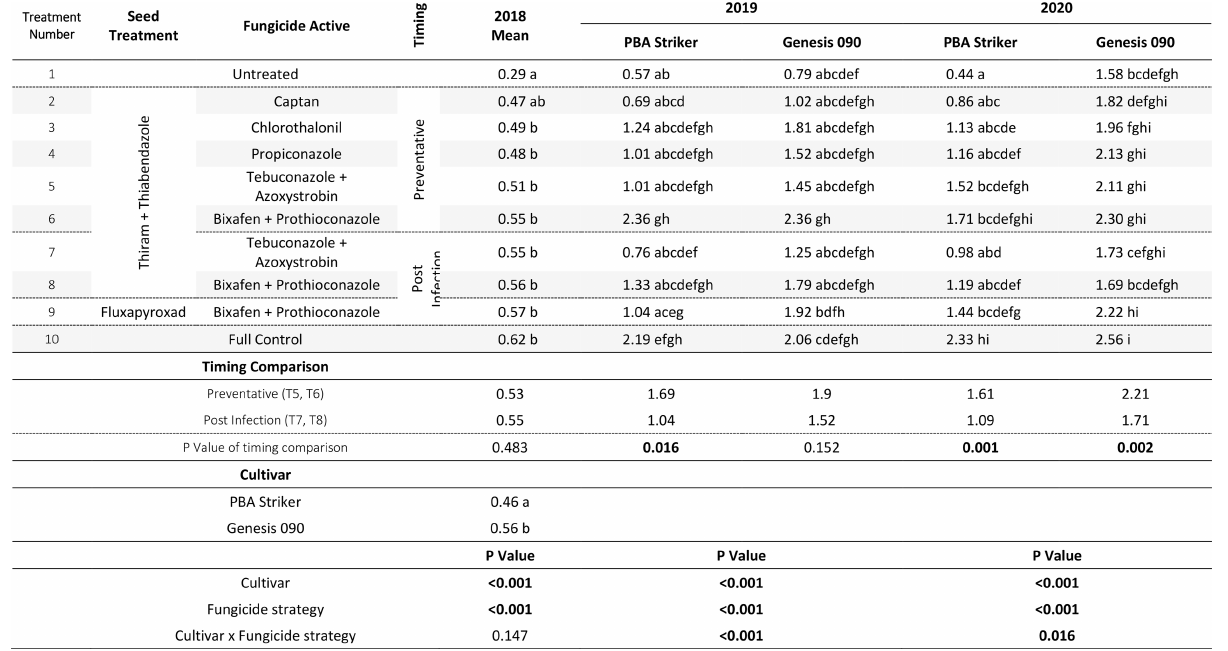
TABLE 7 Chickpea grain yields (t/ha) in the presence of Ascochyta blight for the significant factors in the fungicide by cultivar experiments at Horsham between 2018 and